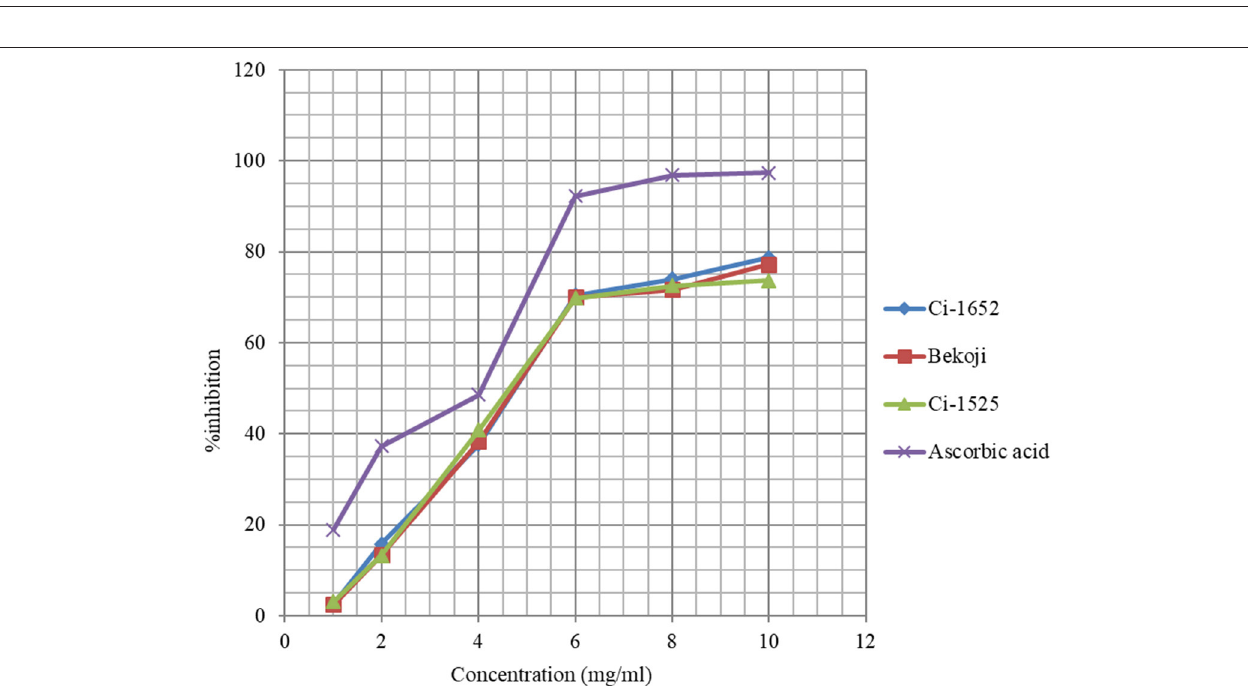
FIGURE 2 | Free Radical scavenging of methanolic extracts of three linseed varieties and the control.